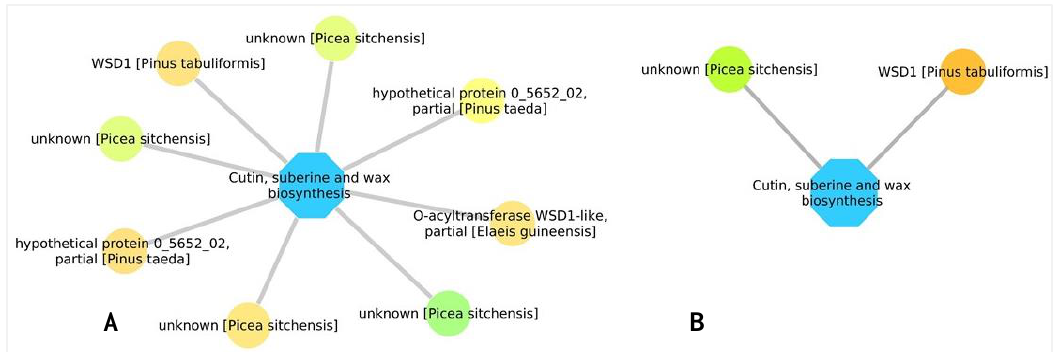
Figure 11. Cutin, suberin, and wax biosynthesis pathway with interactions assigned to DEG in Pinus pinaster ( A ) and in Pinus yunnanensis ( B ) at the first time point after inoculation (6 + 24 h). The blue node represents the pathway. The circular nodes represent DEG related to the pathway. Note that due to the complexity of representing the expression values of those genes in all the stages, the expression was colored on an RGB scale that goes from the most down-regulated in red to the most up-regulated in green.